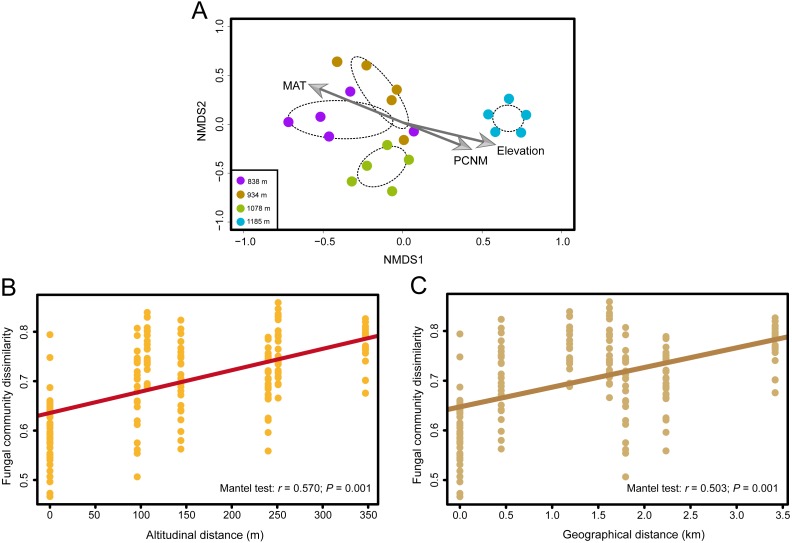
The effects of elevation gradient, geographical distance and climate factor on the fungal community composition.(A) Nonmetric multidimensional scaling (NMDS) ordination of variation in community structure (Bray–Curtis dissimilarity) of the phyllosphere fungal assemblages. The arrow represents significant (P < 0.01) vectors chosen by the “envfit” function to fit the fungal communities. (B) Correlations between altitudinal distance and Bray–Curtis dissimilarities of the phyllosphere fungal community. (C) Correlations between geographical distance and Bray-Curtis dissimilarities of the phyllosphere fungal community. Mantel test results are shown on the figures.